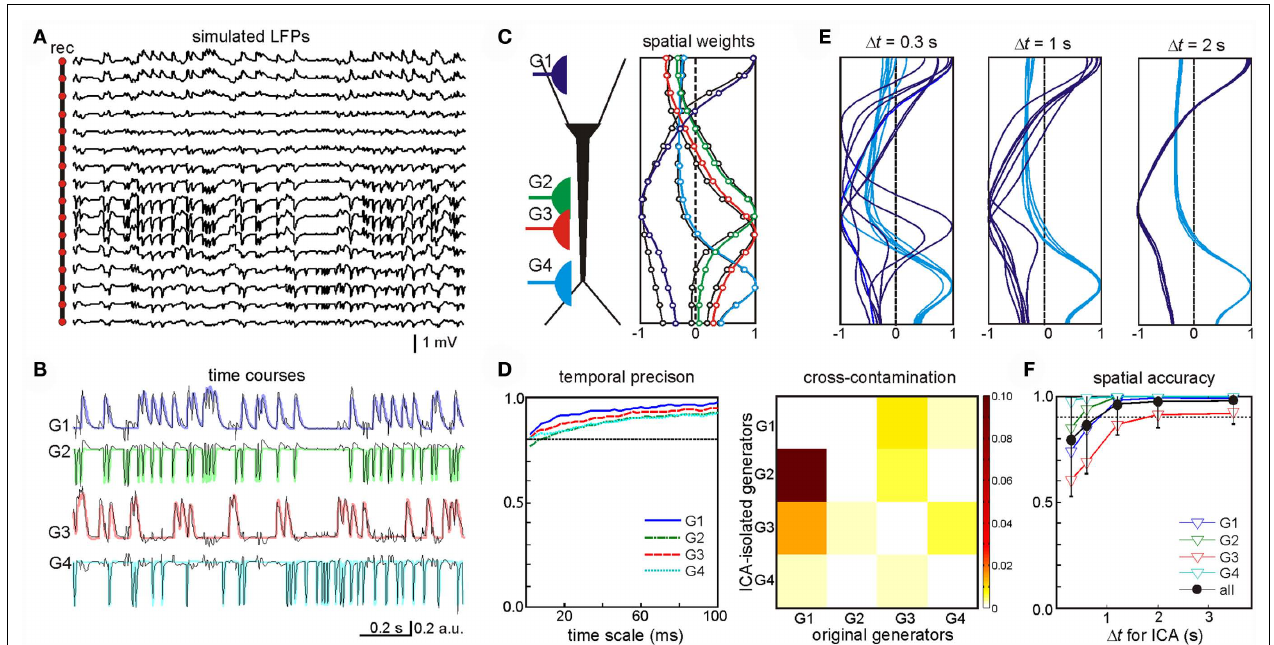
courses is kept up to the millisecond time scale. Right: index of cross-contamination of each generator to all others. Note the low cross-contamination level. (E,F) The LFP-generators require a different minimum duration of LFPs for the ICA to separate them optimally.The plots correspond to seven different segments of increasing duration for two of the generators [G1 and G4, (E) ]. Note the faster convergence of the spatial curves in G4.The spatial jitter was associated to the degree of coincidence of each generator with other inputs. For durations longer than 3s all generators showed acceptable spatial accuracy (F)